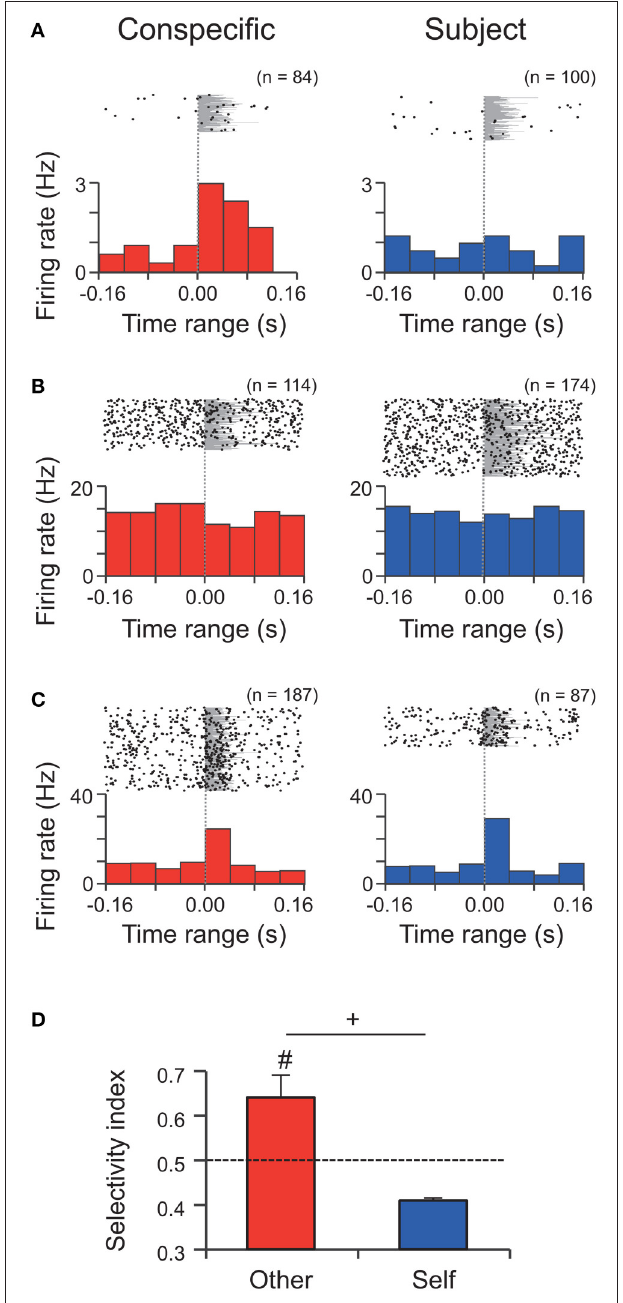
FIGURE 4 | Single unit activity during WFM calls by the conspecific and the subject in M sessions. (A–C) Perievent rasters and histograms of three neurons (A) an excitatory Type-Other neuron; (B) an inhibitory Type-Other neuron; (C) an excitatory Type-Both neuron. Bin widths = 40ms. Time zero represents onset of the call. Each number (n) at the top right of the panel indicates the number of calls analyzed. Gray shading indicates the call durations. (D) The response selectivity (selectivity index, SI) of Type-Other and Type-Self neurons. The dashed line indicates the expected value if responses to the WFM calls by the conspecific and subject were equal. #, significantly different from the expected value, p < 0.05, Wilcoxon signed rank test; + , tendency of the difference between Type-Other and Type-Self neurons, p < 0.1, Wilcoxon rank sum